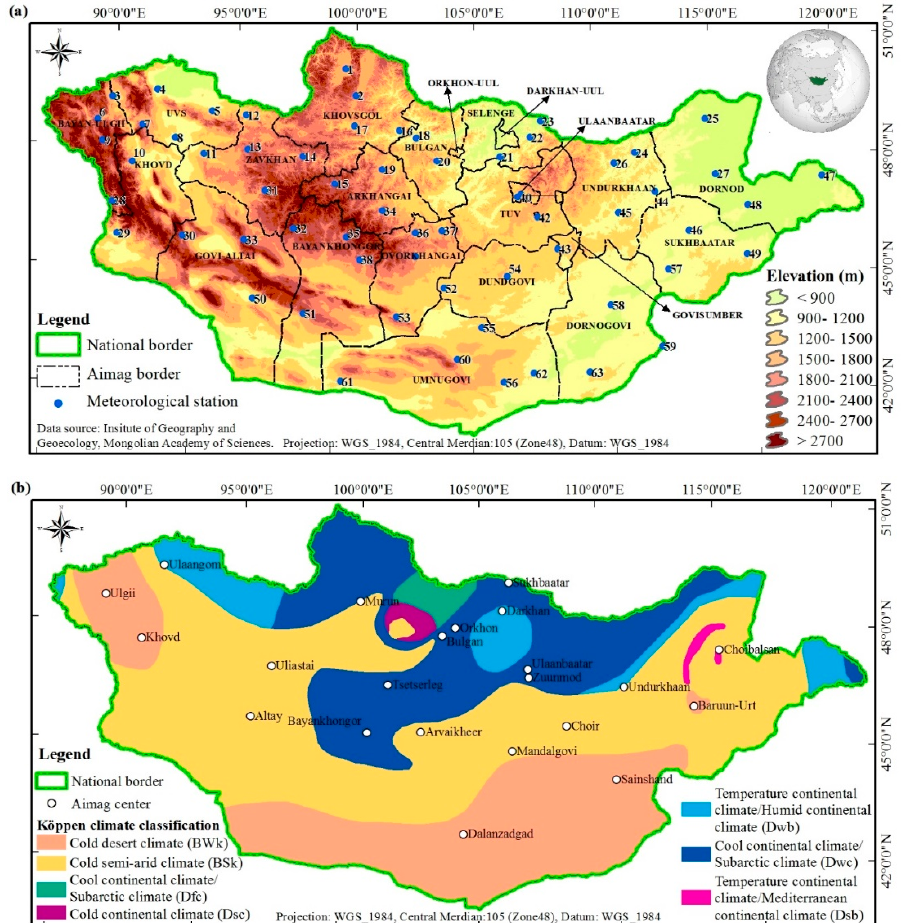
Figure 1. Mongolia: ( a ) Topography and location of meteorological stations ( n = 63) for which reference air temperature information from automatic weather stations was available. The digital elevation model (DEM) was derived from the Shuttle Radar Topography Mission (SRTM-DEM) with a resolution of 90 m. ( b ) Köppen climate classification of Mongolia based on long-term meteorological conditions (>30 years) [51].